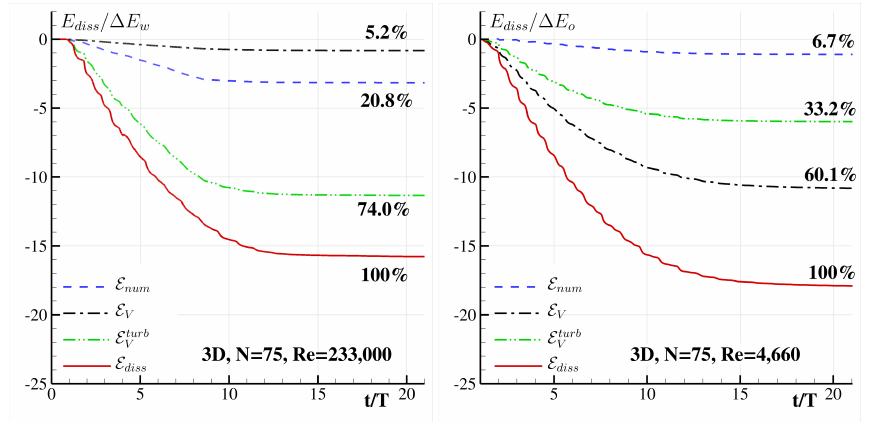
Figure 14. Energy dissipation due to real, turbulent and numerical viscosity for 3D simulations at the maximum resolution N = 75. ( Left ) water test-case. ( Right ) oil